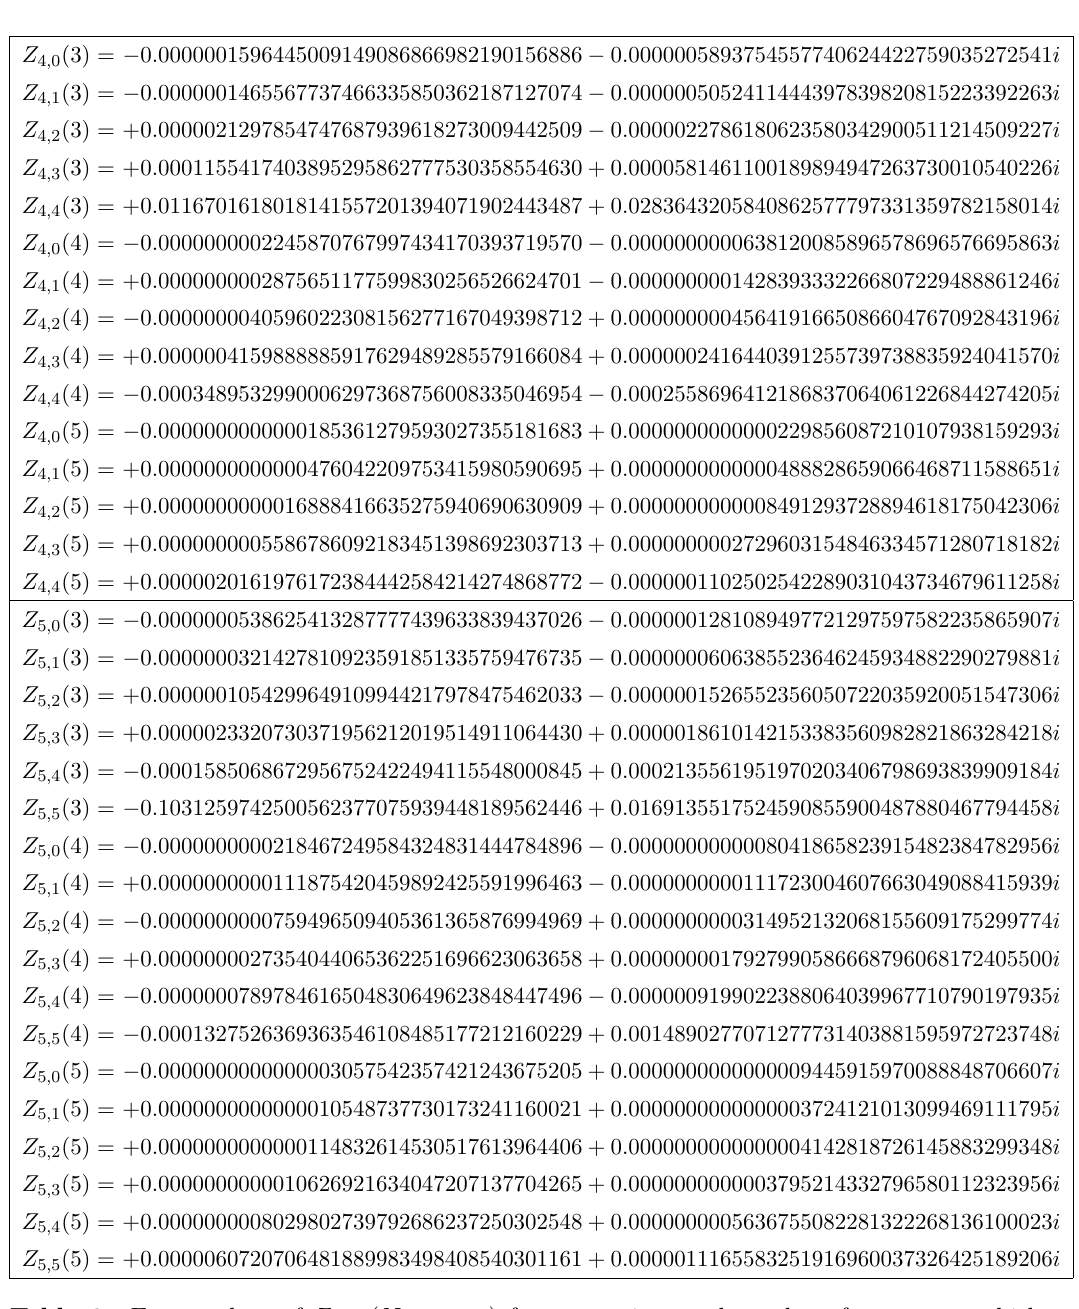
Table 2 . Exact values of Z k,M ( N, m 1 , m 2 ) for a generic complex value of m 1 = m 2 which we √ √ have chosen as m 1 = m 2 = ( 2 + 3 i ) / 2 . Together with the exact values of Z k,M ( N, m 1 , m 2 ) for N = 1 , 2 in appendix B.1, the displayed digits of the numerical values of Z k,M ( N, m 1 , m 2 ) for N ≥ 3 are sufficient for checking the bilinear relation (3.1) at order ∼ 10 − 35 which is smaller than the values of Z k,M ( N, m 1 , m 2 )